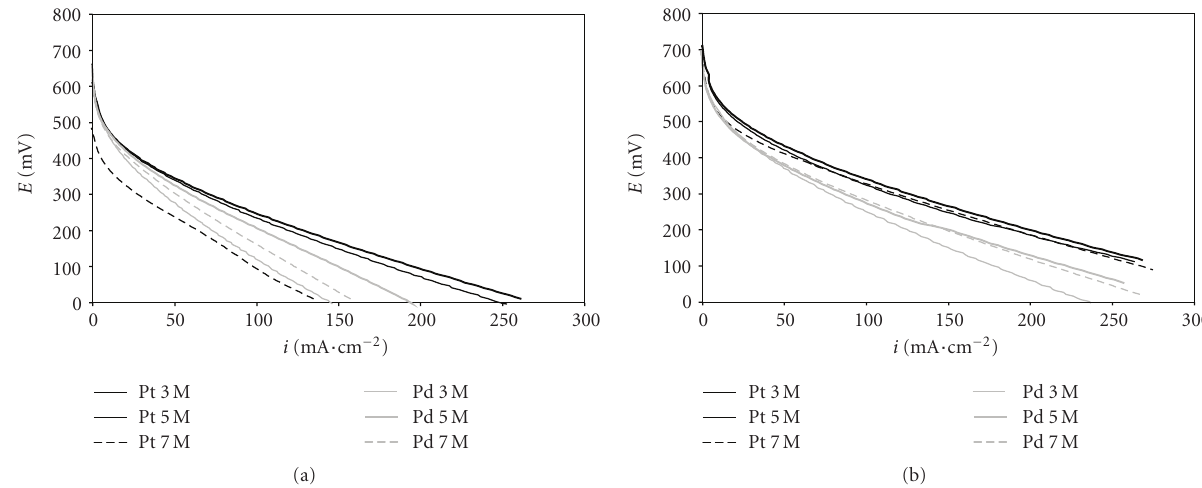
Figure 6: (a) Comparison of polarization curves of a direct methanol fuel cell operating with air with Pd/C and commercial Pt/C from E-tek as cathode catalyst at 60 ◦ C and 3, 5, and 7M methanol. (b) Comparison of polarization curves of a direct methanol fuel cell operating with oxygen with Pd/C and commercial Pt/C from E-tek as cathode catalyst at 60 ◦ C and 3, 5, and 7M methanol.